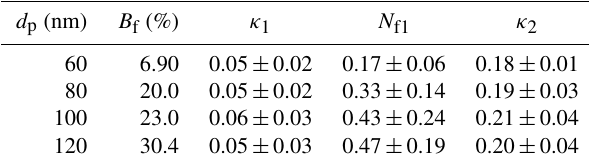
Table 3. Percentage of externally mixed samples ( B f ) , the hygro- scopic parameter of the less and more hygroscopic mode ( κ 1 ,κ 2 ) , respectively, and the number fraction of particles residing in the less hygroscopic mode ( N f1 ) during the Chios event (20–21 Au- gust